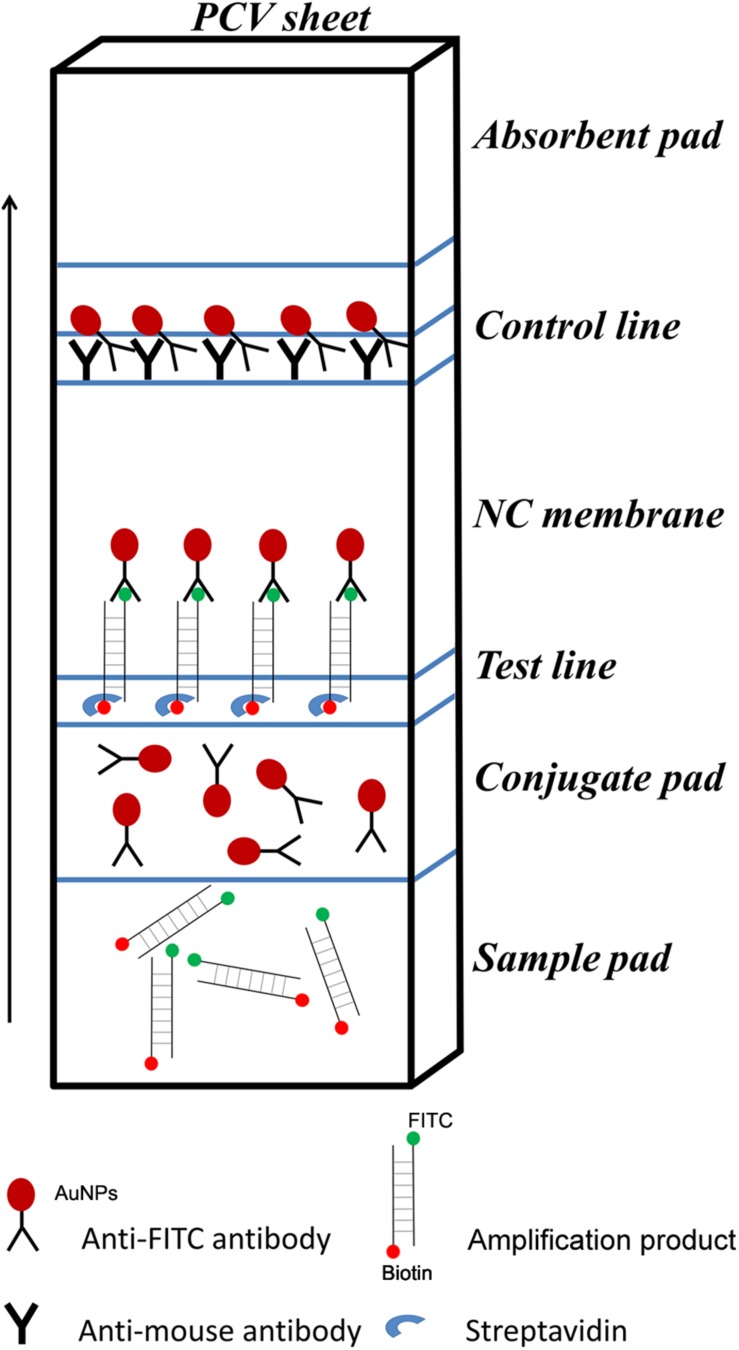
Schematic representation of the lateral flow strip (LFS) working principle. The borders of segments on the strip were indicated by blue lines. The names of the segments were indicated on the right of the strip drawing. The coating material on each segment of the strip was indicated by a shape. The liquid migration direction is indicated by an arrow. Molecules could be trapped by the materials on the Test line and the Control line, which were also indicated by different shapes. Shapes and their representing molecules were listed under the strip drawing.